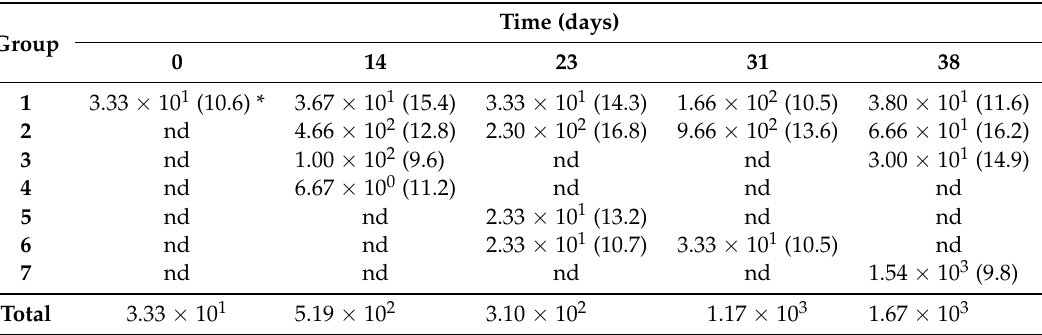
Table 1. Count of different yeast populations (cfu/mL).